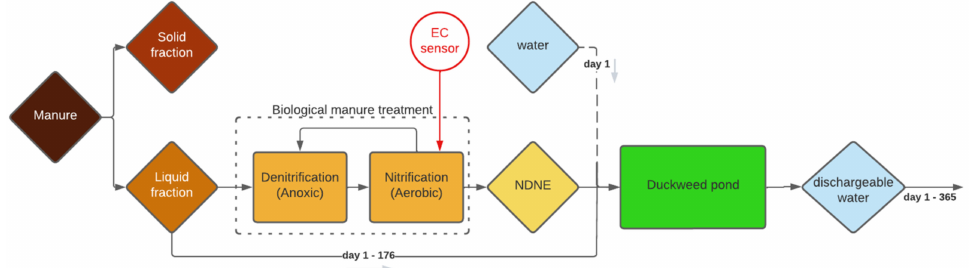
Figure 1. Schematic representation of the manure treatment process with centrifugal separation as the first step, biological treatment as the second step (with nitrification-denitrification = NDN) and a duckweed pond as the third and final treatment step. The duckweed pond in this scheme is not yet applied in practice, the other treatment steps are presented in the same order as they occur at IVACO, a pig manure treatment plant in Flanders (Belgium),